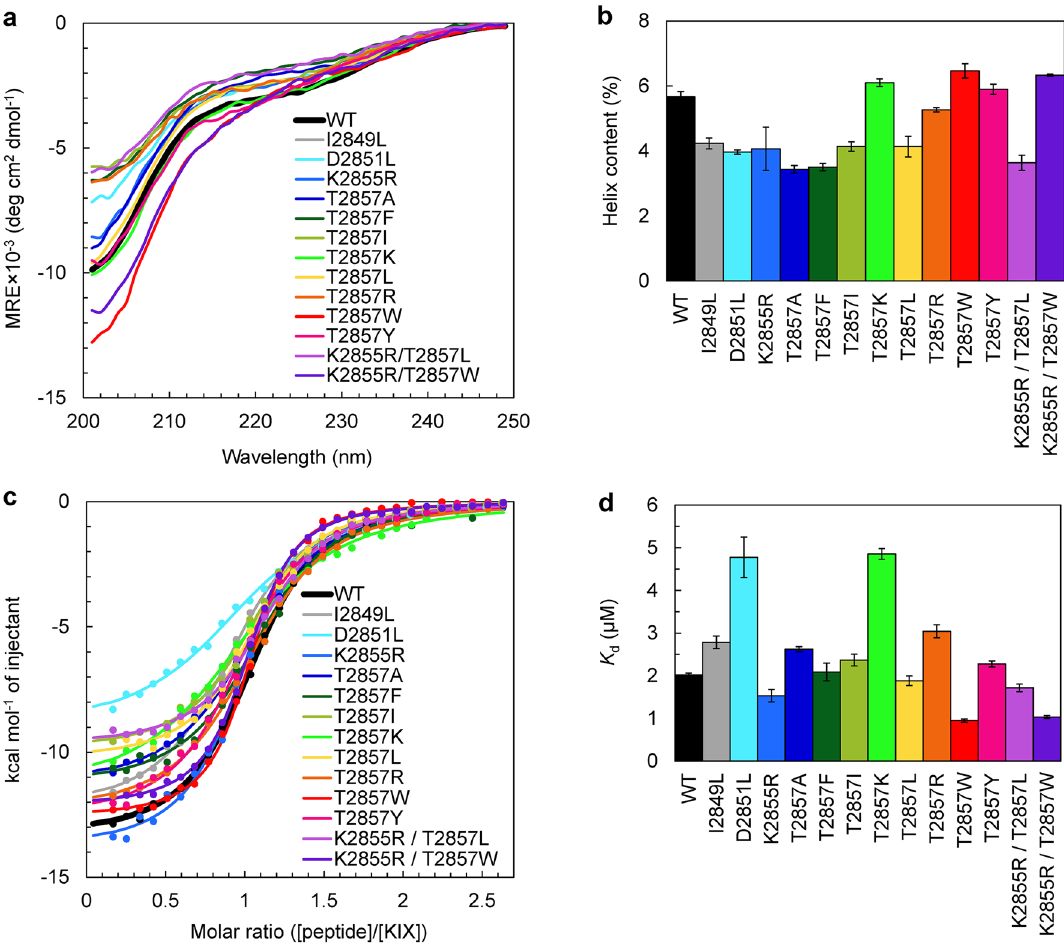
Figure 4. Secondary structure and KIX-binding affinity of the wild type and mutants of the MLL TAD. ( a ) Far-ultraviolet circular dichroism (CD) spectra of the MLL TAD peptides. ( b ) The helix contents estimated from the CD spectra. ( c ) KIX-binding isotherms of the wild type and mutants of the MLL TAD measured using isothermal titration calorimetry (ITC). The continuous lines are the curves fitted to a one-site binding model. ( d ) The K d values obtained from the ITC measurements. In ( b ) and ( d ), the mean and standard error of triplicate or more measurements are shown. The figures were created with Microsoft Excel for Microsoft 365 (Microsoft Corp., Redmond, WA, USA; https:// www. office.